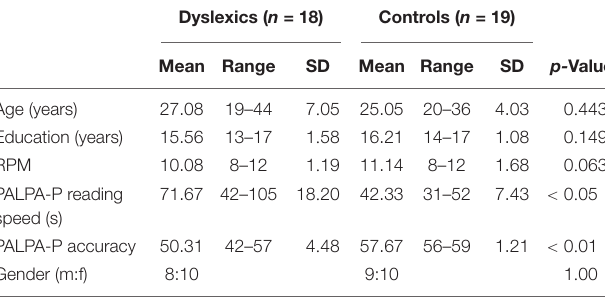
TABLE 1 | Summary statistics for the two groups of